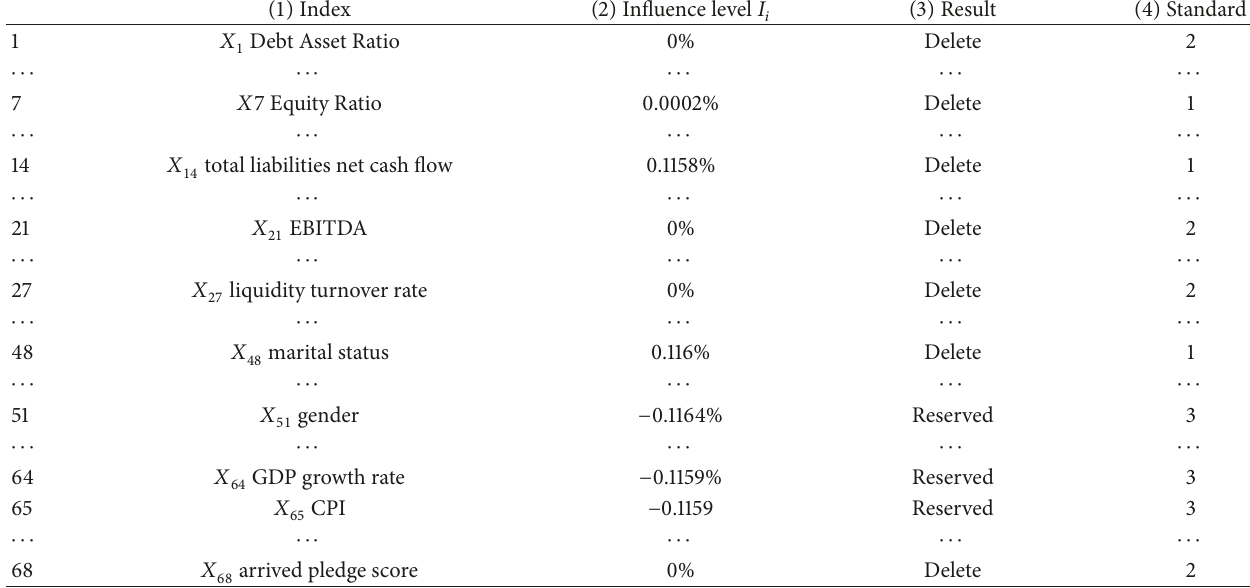
Table 3: The result of indicator screening based on nonparametric 𝐾 -nearest neighbor identification model.